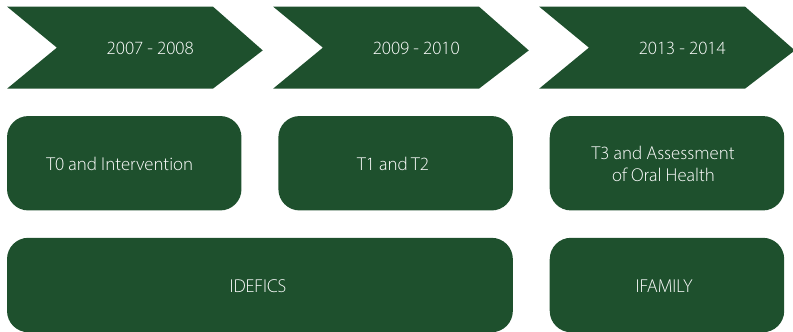
Figure A. Schedule of exams of the IDEFICS cohort and the IFAMILY study. T0, Initial research phase (baseline); T1, first exam after intervention; T2, questionnaires sent to participants via postal